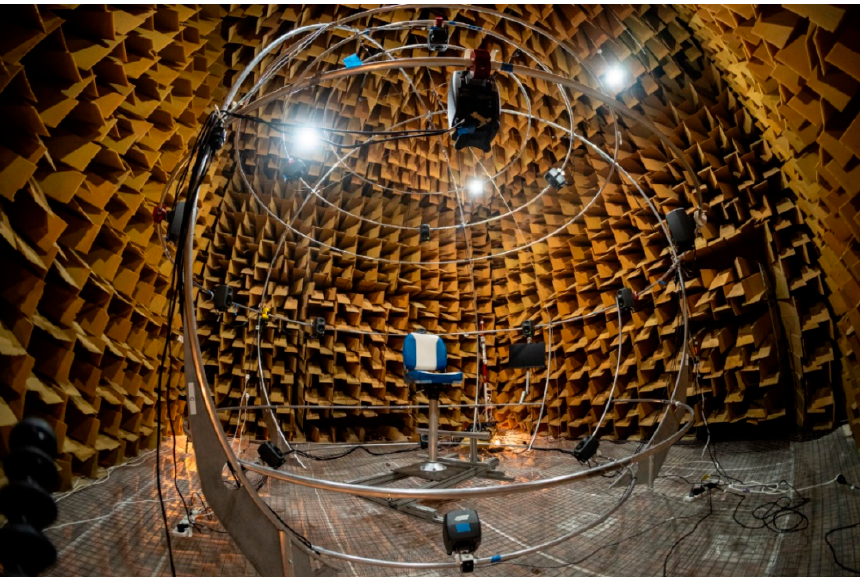
Figure 3. Sixteen-channel spherical loudspeaker array setup in the anechoic chamber at the University of Auckland (taken from [51]).